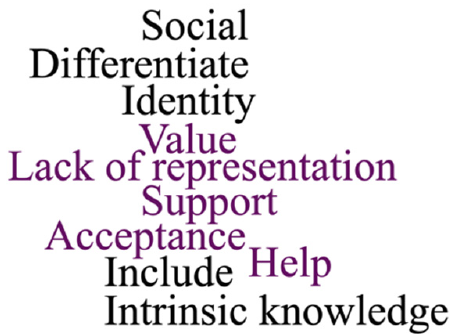
Figure 3. Common responses regarding CLA and transformation.